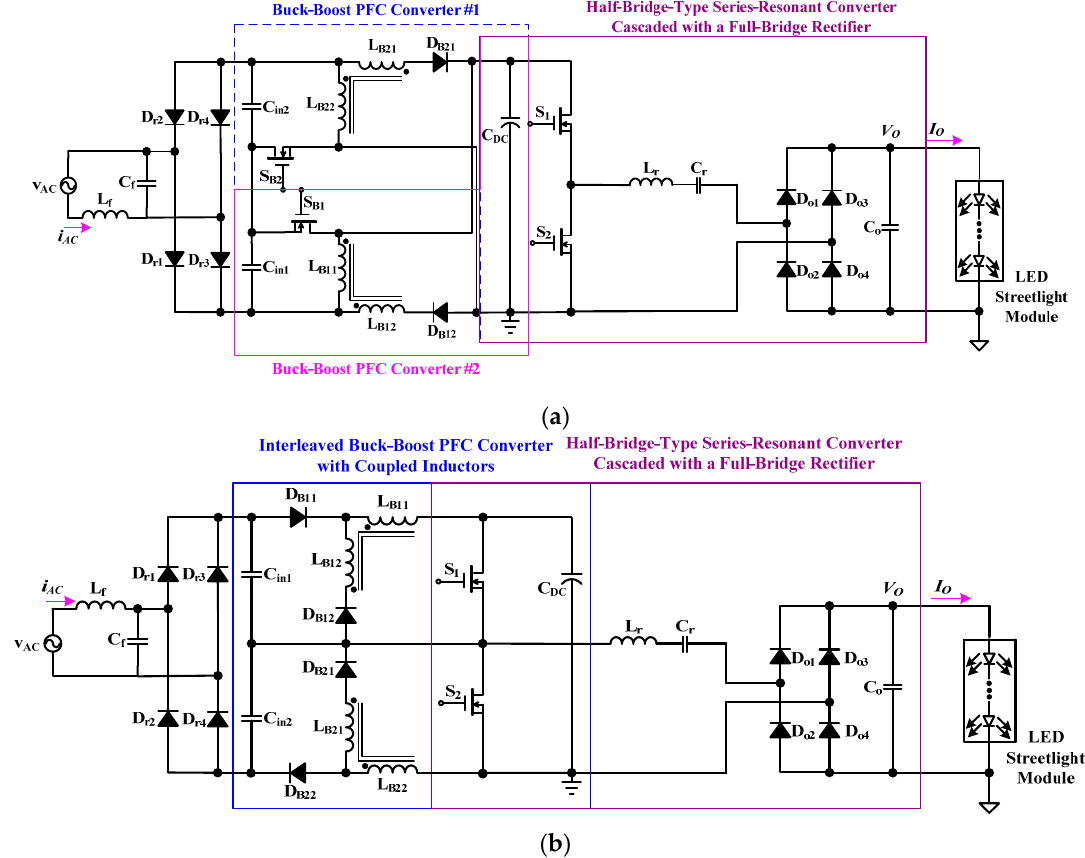
Figure 2. ( a ) Original two-stage LED driver circuit; ( b ) the presented single-stage LED driver with coupled inductors and interleaved PFC for streetlight applications. coupled inductors and interleaved PFC for streetlight